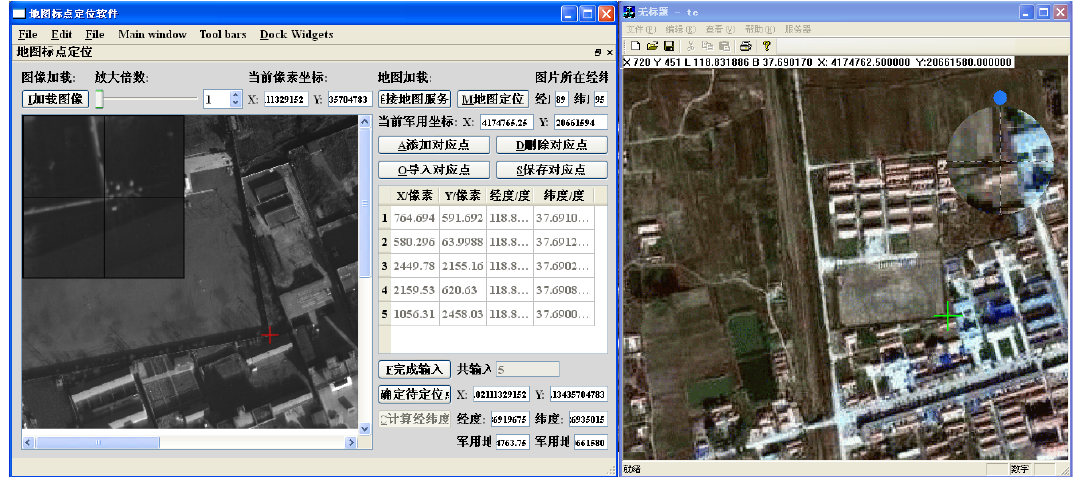
Figure 2. The appearance of location